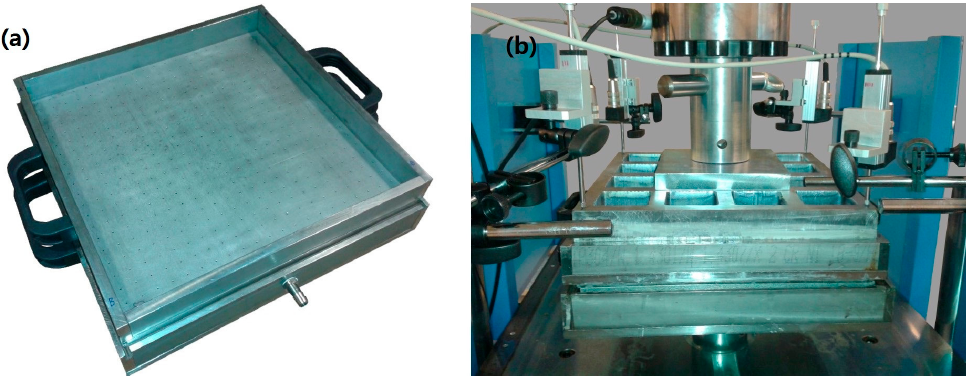
Figure 8. Photographic images of the mold used to prepare the composites ( a ) and the pressing process used for its compaction ( b ).